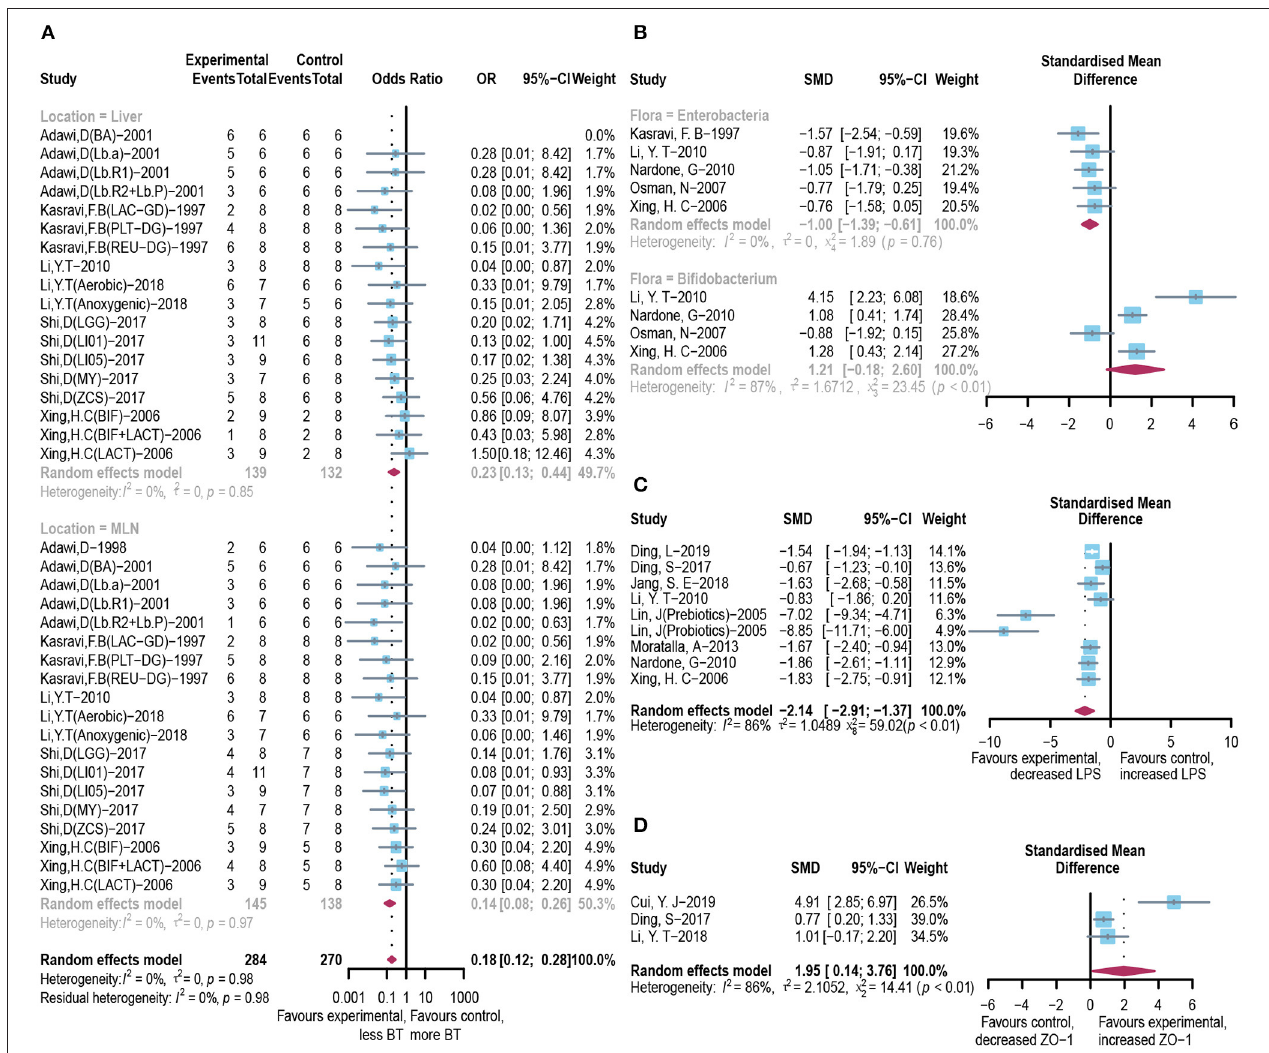
FIGURE 4 | Effectiveness of microbial agents on BT. (A) The effect of microbial agents on BT to liver or mesenteric lymph node. (B) The effect of microbial agents on the abundance of Enterococcus and Bifidobacterium in the ileocecal region. (C) The effect of microbial agents on the level of LPS. (D) The effect of microbial agents on the expression of tight junction protein